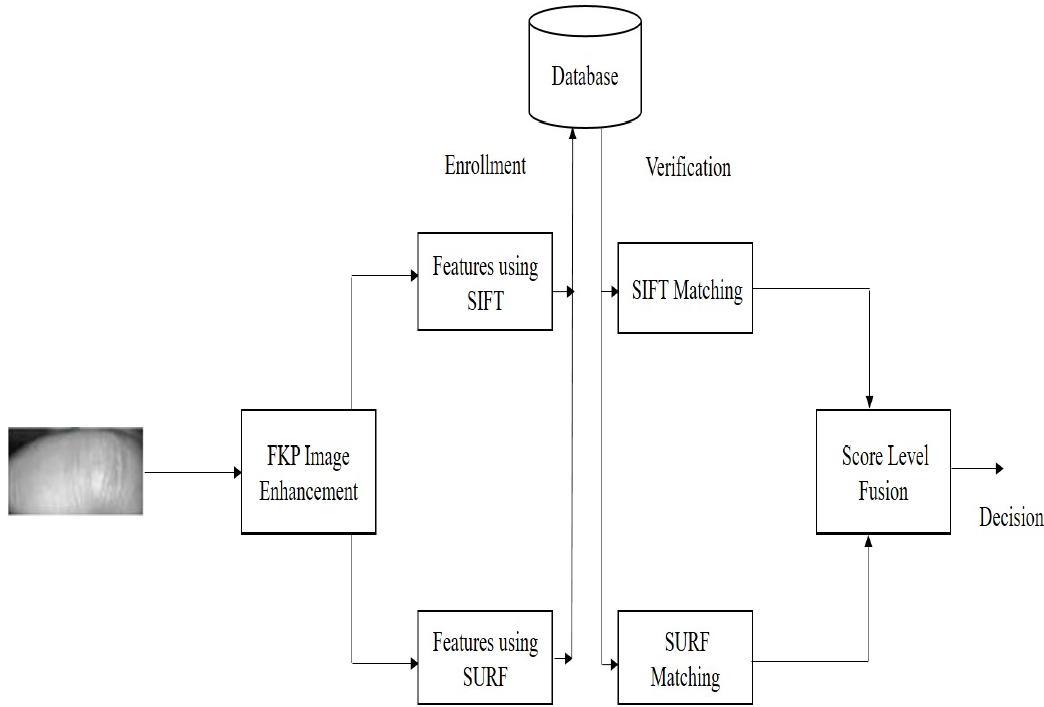
Figure 4. Proposed FKP method.